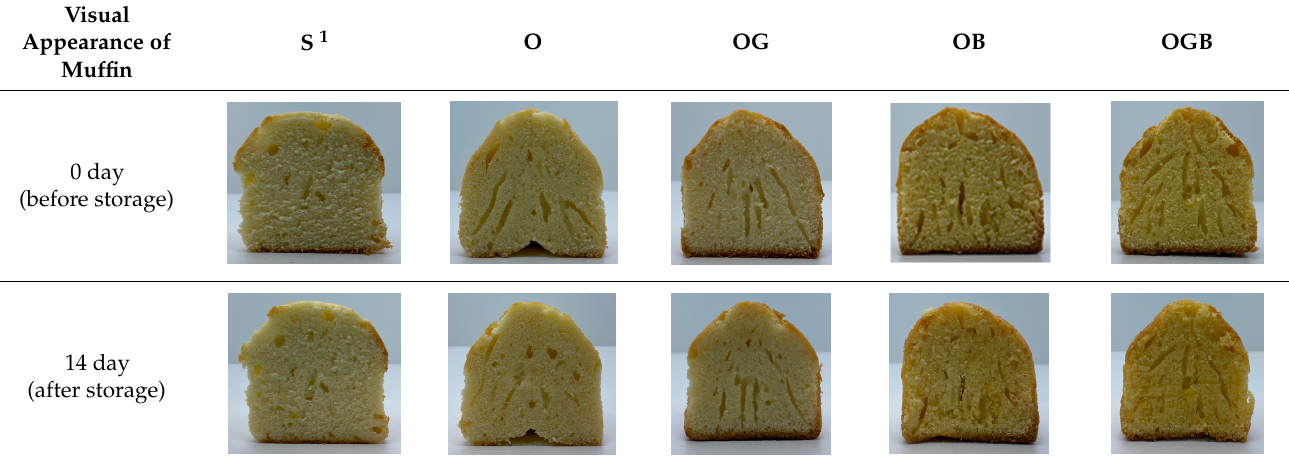
Samples were named oleogel (O), oleogel with GMS (OG), oleogel with β -carotene (OB), and oleogel with GMS and β - carotene (OGB). Values are means ± standard deviation ( n = 3). Means with different small letters in the same column differ significantly by Duncan test ( p < 0.05). Table 2. Effect of shortening replacement with oleogels on the visual appearances of muffins.